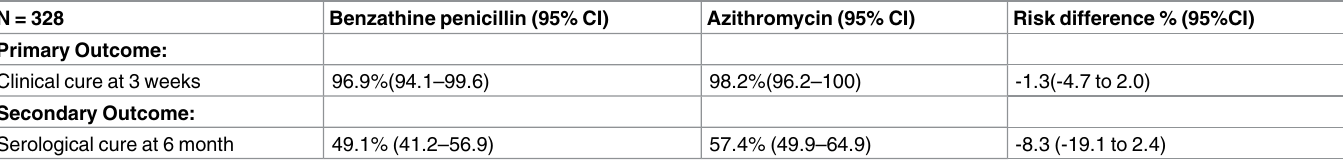
Table 2. Treatment Outcomes (PP).